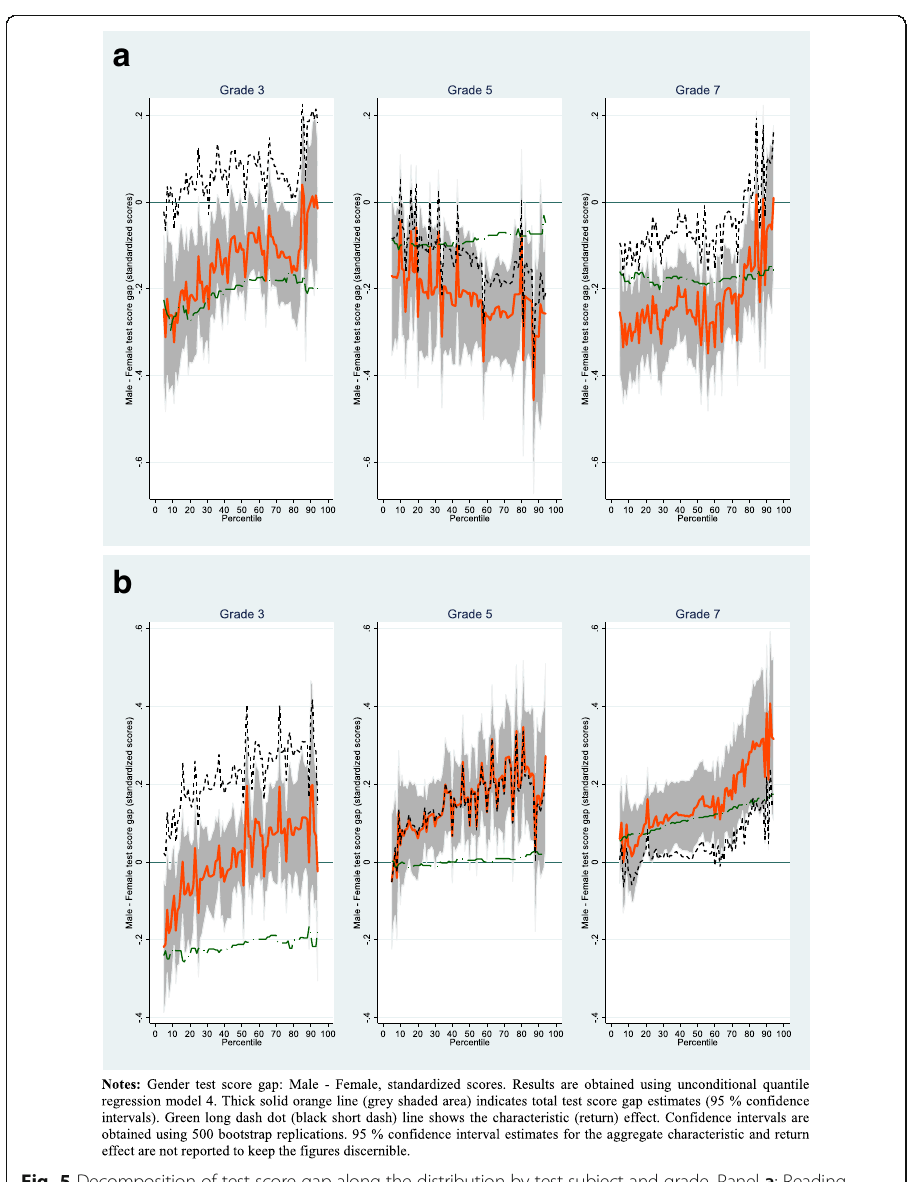
Fig. 5 Decomposition of test score gap along the distribution by test subject and grade. Panel a : Reading. Panel b :